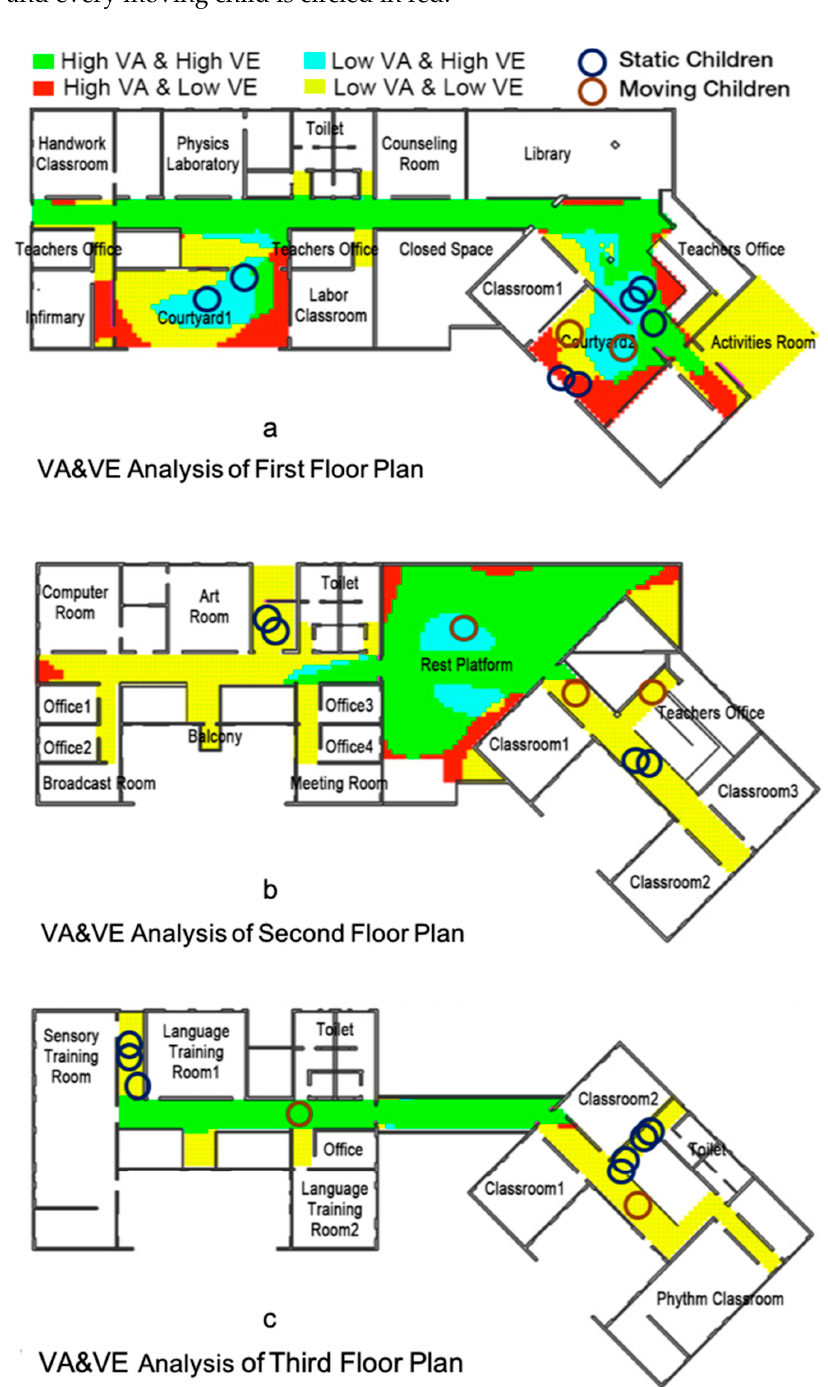
Figure 5. The VA and VE situation and the children’s spatial positions in the Deyin and Deyi Buildings: ( a ) first floor, ( b ) second floor, ( c ) third